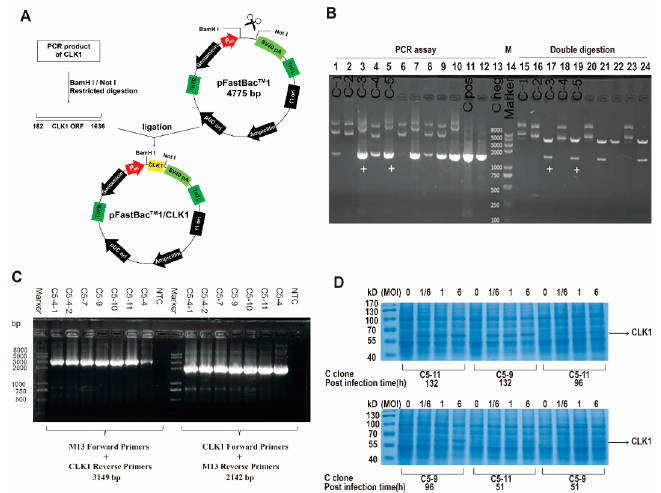
Figure 1. Construction of CLK1/pFastBac1 plasmid and the protein expression of CLK1 in insect cells. ( A ) A schematic of the steps to construct CLK1/pFastBac1 recombinant plasmid; ( B ) Identification of the constructed CLK1/pFastBac1 recombinant plasmid by both colony PCR assay and double digestion. C-1~5: clone 1 to 5. Cpos: positive clone. Cneg: negative clone; ( C ) Identification of recombinant bacmid CLK1/pFastBac1 by PCR analysis. NTC: non-template control; ( D ) Determination the optimal conditions to express the recombinant protein His 6 -CLK1 by Coomassie Brilliant Blue staining.